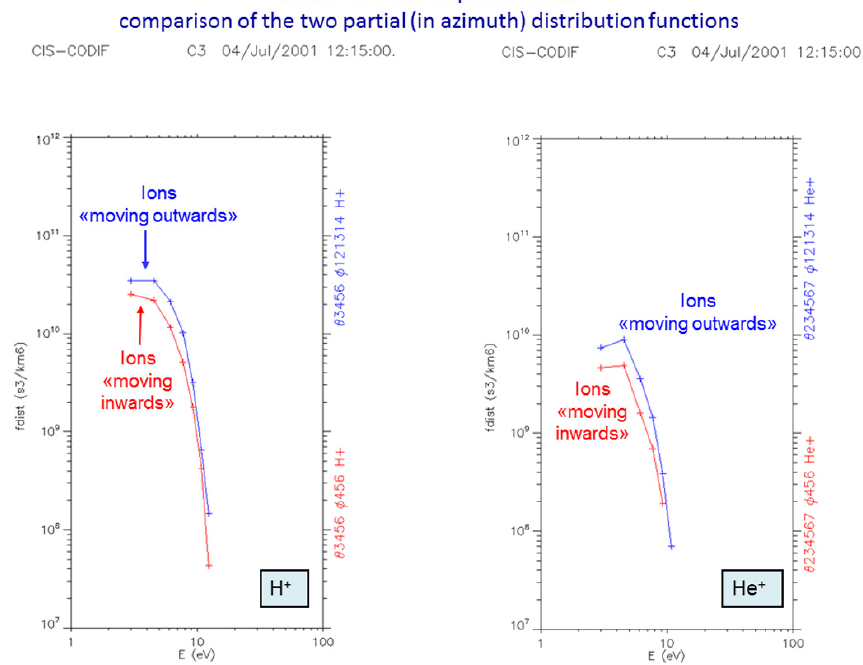
Fig. 8. Partial distribution functions in the outer plasmasphere and close to the magnetic equator, corresponding to ions flowing radially outwards (blue plots) and to ions flowing radially inwards (red plots). Left panel is for H + ions and right panel is for He + ions. Ordinate axis is in phase space density units (ionss 3 km − 6 ). The systematic imbalance between the outwards and inwards propagating ions reveals a net outward flow.